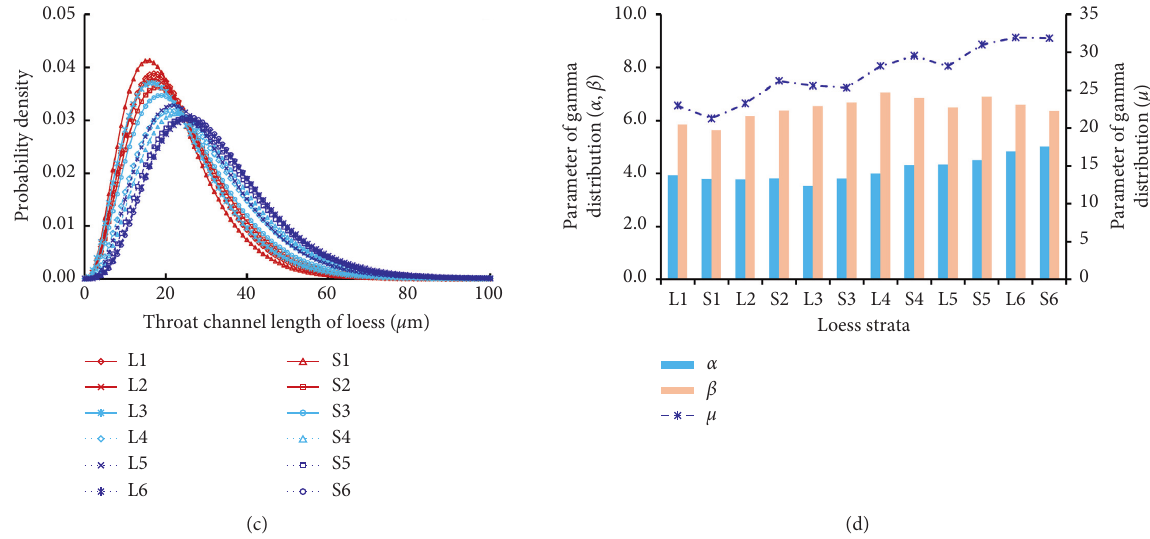
Figure 10: Distribution characteristics of throat channel length: (a) probability density versus channel length of L1; (b) probability density versus channel length of S1; (c) distribution characteristics of channel length for various layers; (d) variation in fitting parameters for various layers of